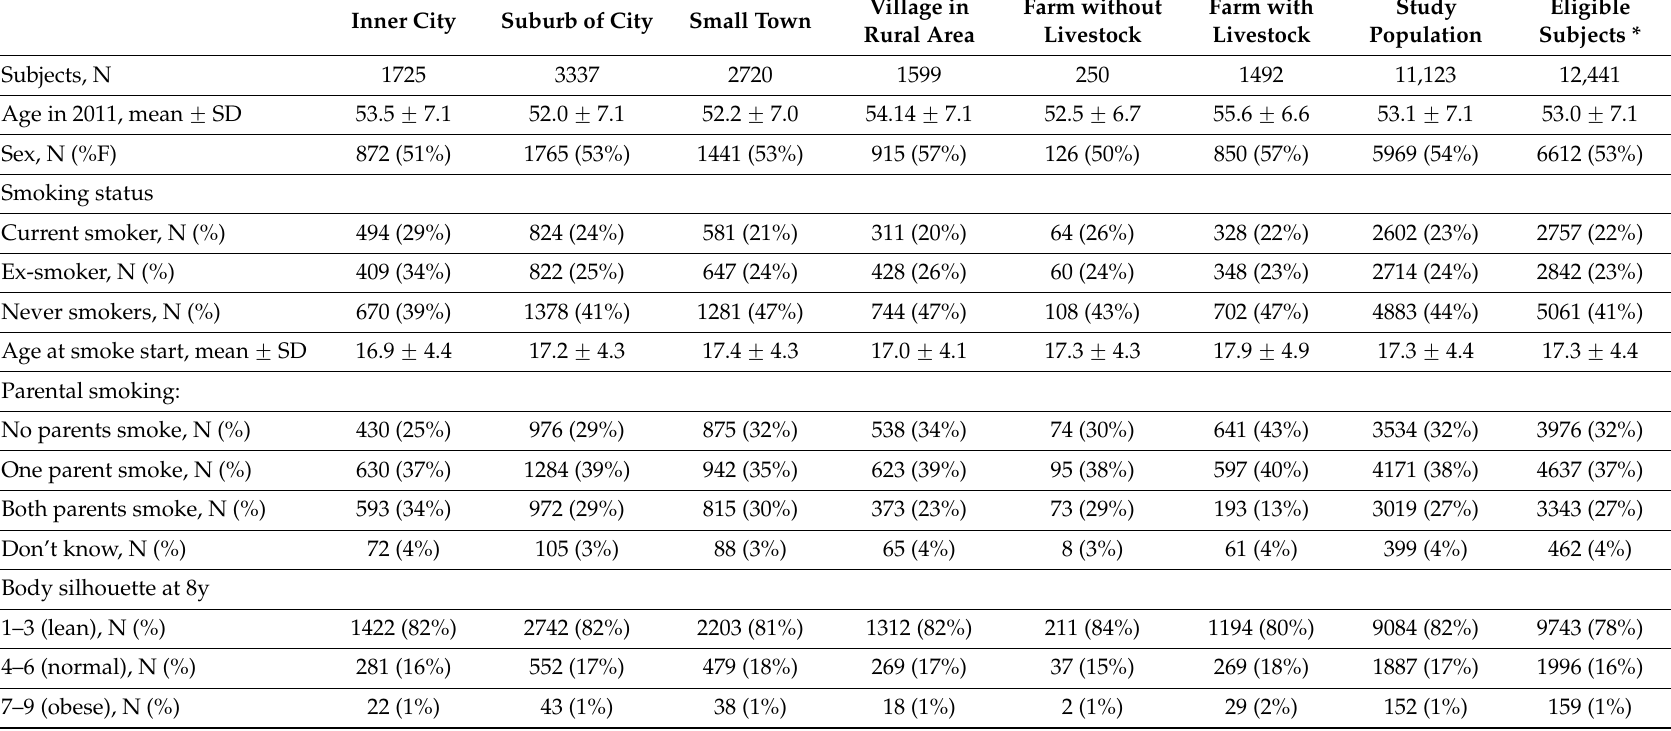
Table 1. Characteristics of the study population and the eligible